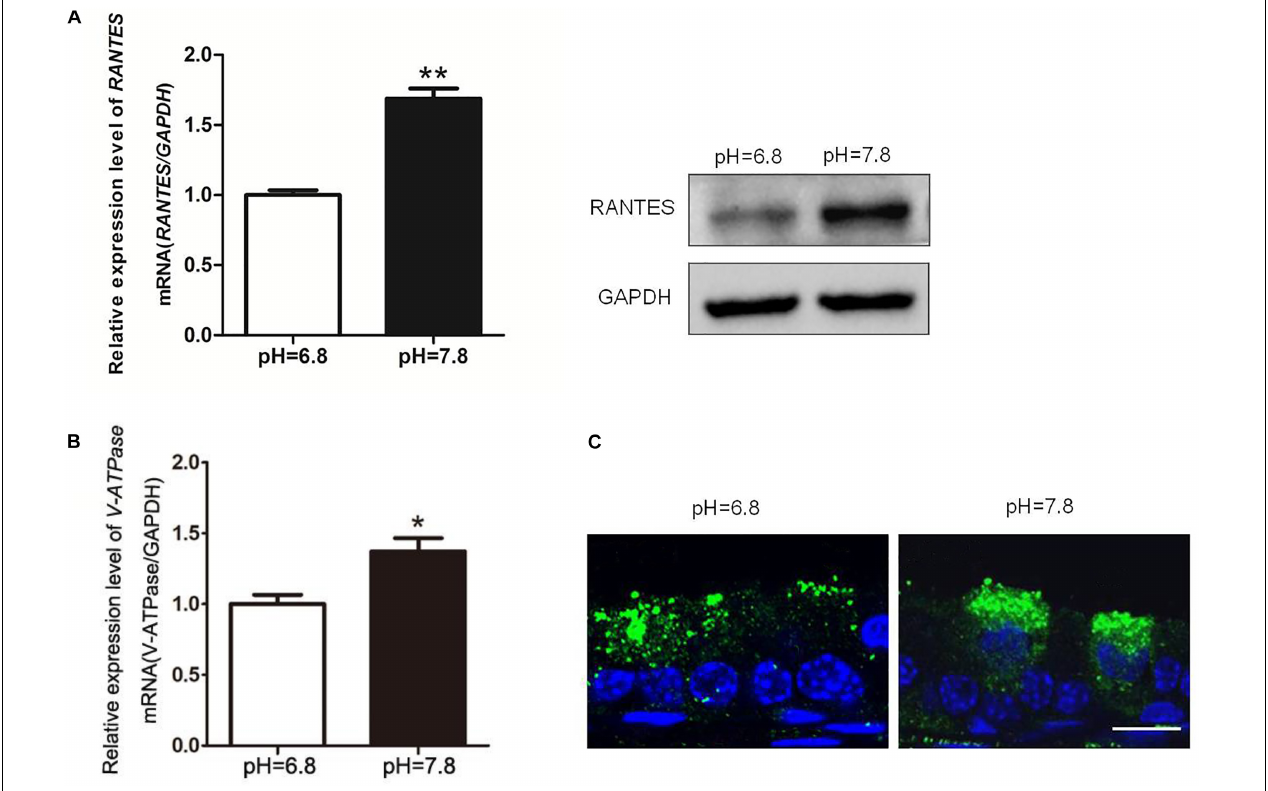
FIGURE 4 | Changes of RANTES and V-ATPase upon rat cauda epididymis alkaline perfusion. Rat cauda epididymal lumen was perfused in vivo with PBS (pH values 6.8 or 7.8). (A) Real-time PCR and WB revealed that upon alkaline treatment (pH of 7.8), the expression level of RANTES in cauda epididymis was significantly up-regulated compared with that in the control group (pH of 6.8). Meanwhile, (B) expression of V-ATPase mRNA was increased examined by real-time PCR, N = 5–6. (C) The Results of CLSM showed that the alkaline pH also induced the apical accumulation of V-ATPase in the clear cell. ** P < 0.01, * P < 0.05, N = 5–6, Bar = 20 µ